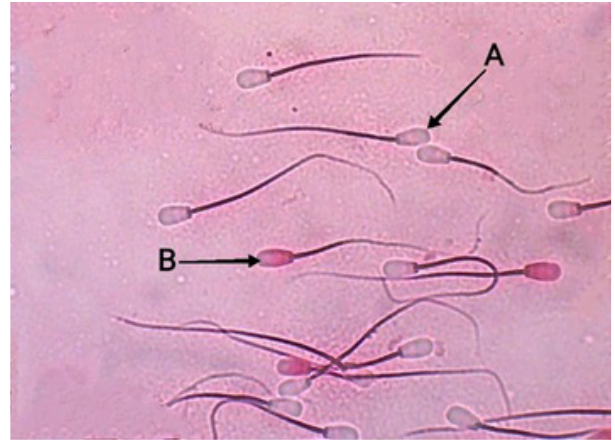
Figure 2. Sperm viability of Bali bulls ( Eosin-nigrosin staining with 400× microscope magnification). (A) Live spermatozoa are colorless or transparent white. (B) Dead spermatozoa characterized by a colored